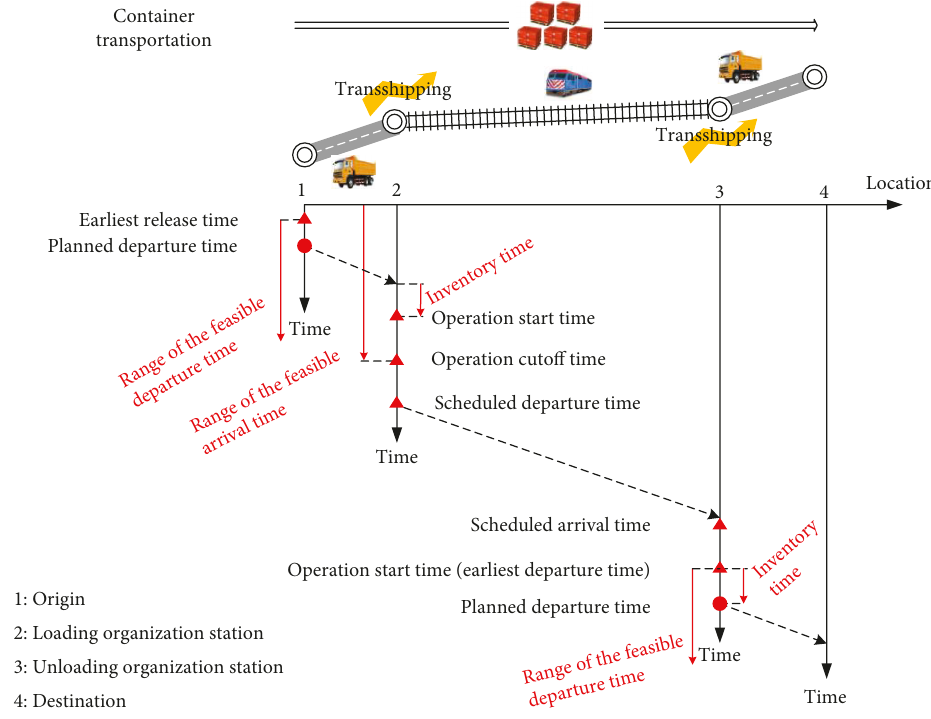
Figure 2: Diagram of a simple road-rail multimodal